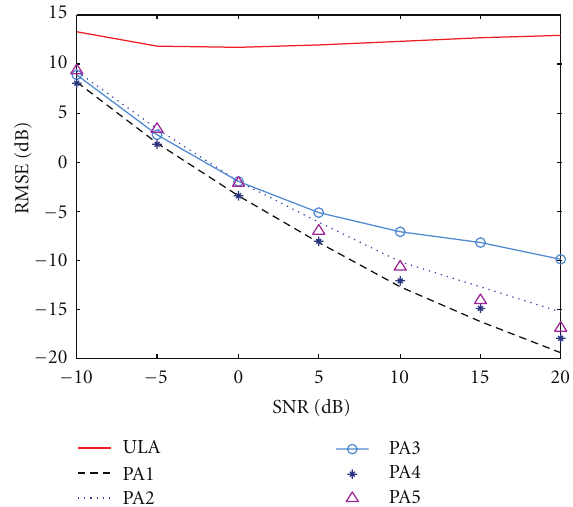
Figure 5: Total RMSE of the MVDR algorithm for di ff erent configurations where signals are arriving at boresight directions.